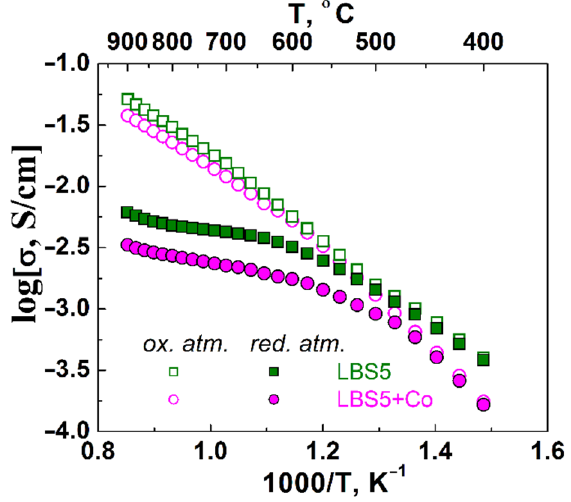
Figure 11. Temperature dependencies of electrical conductivity of La 0.95 Ba 0.05 ScO 3- δ and La 0.95 Ba 0.05 ScO 3- δ + 0.5 wt% Co 3 O 4 ceramics in wet oxidizing and reducing atmospheres.